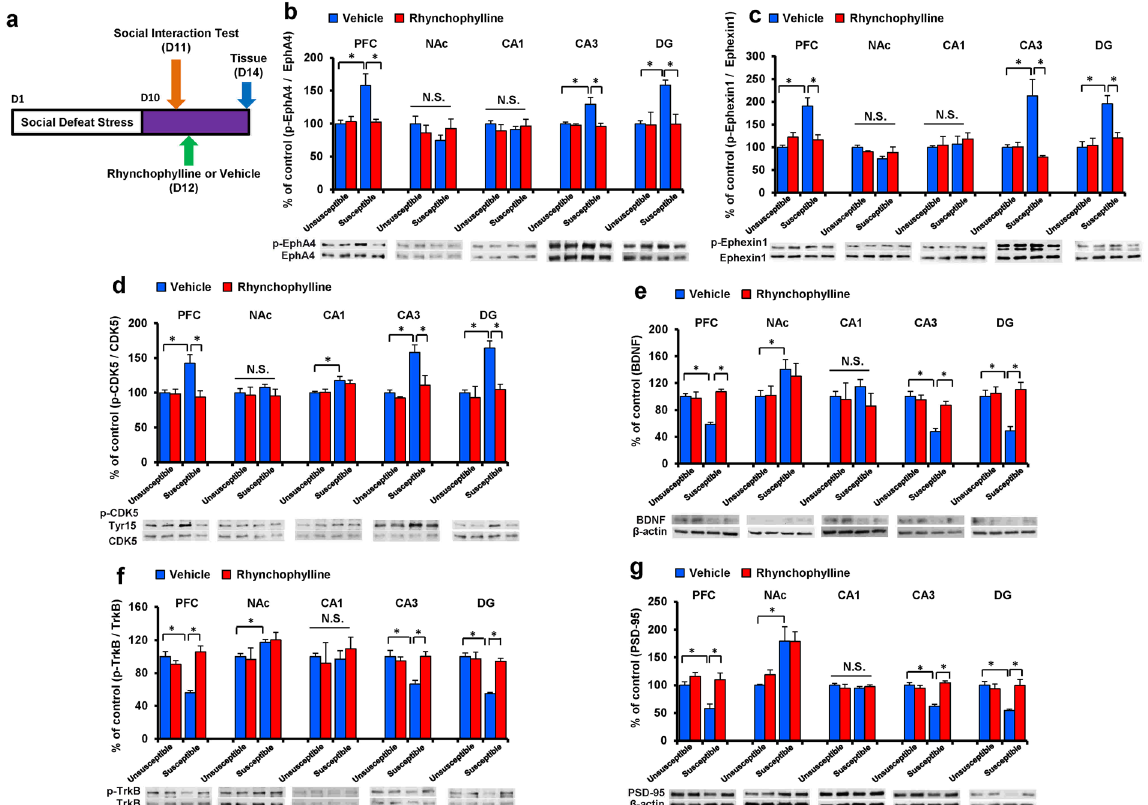
Figure 4. Role of EphA4-ephexin1-Cdk5 signaling, BDNF-TrkB signaling and synaptic protein in the antidepressant effect of rhynchophylline. ( a ) Schedule of social defeat stress (10 days), drug treatment, and brain sample collection. ( b ) Western blot analysis of EphA4 and p-EphA4 in the PFC, NAc, CA1, CA3, and DG of hippocampus. ( c ) Western blot analysis of ephexin1 and p-ephexin1 in the PFC, NAc, CA1, CA3, and DG of hippocampus. ( d ) Western blot analysis of p-Cdk5 (Tyr15)/Cdk5 in the PFC, NAc, CA1, CA3, and DG of hippocampus. The values are expressed as percentages relative to those in the control mice. The values represent the mean ± S.E.M. (n = 5 or 6). * P < 0.05 compared with the vehicle + stressed group. N.S.: not significant. ( e ): Western blot of BDNF in the PFC, NAc, CA1, CA3, and DG of hippocampus. ( f ): Western blot analysis of TrkB and p-TrkB in the PFC, NAc, CA1, CA3, and DG of hippocampus. ( g ): Western blot analysis of